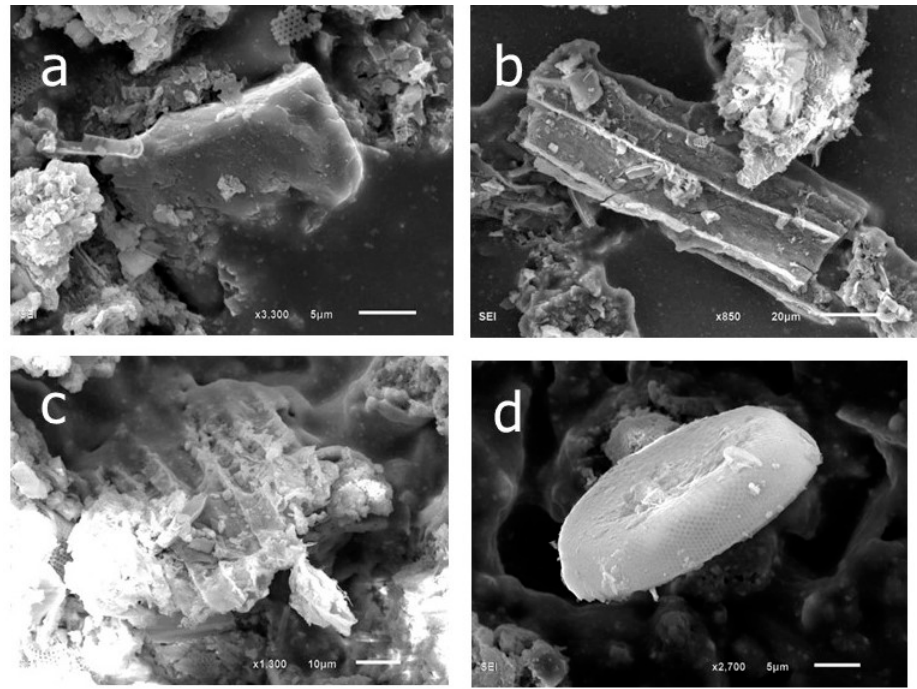
Figure 3. Organic and silica microbiomorphs revealed in the lagoonal sediments: a— phytolith of